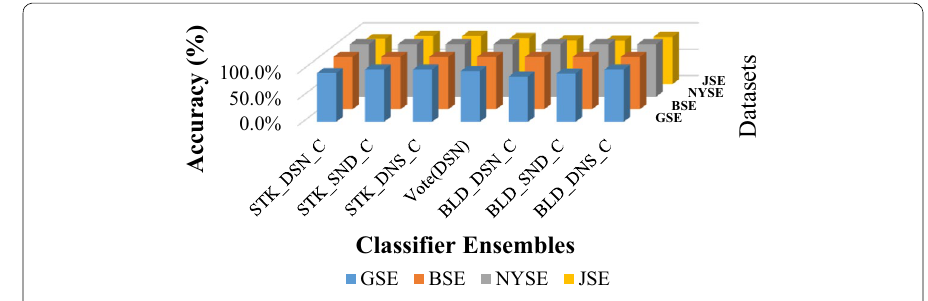
Fig. 10 Heterogeneous ensembles by stacking and